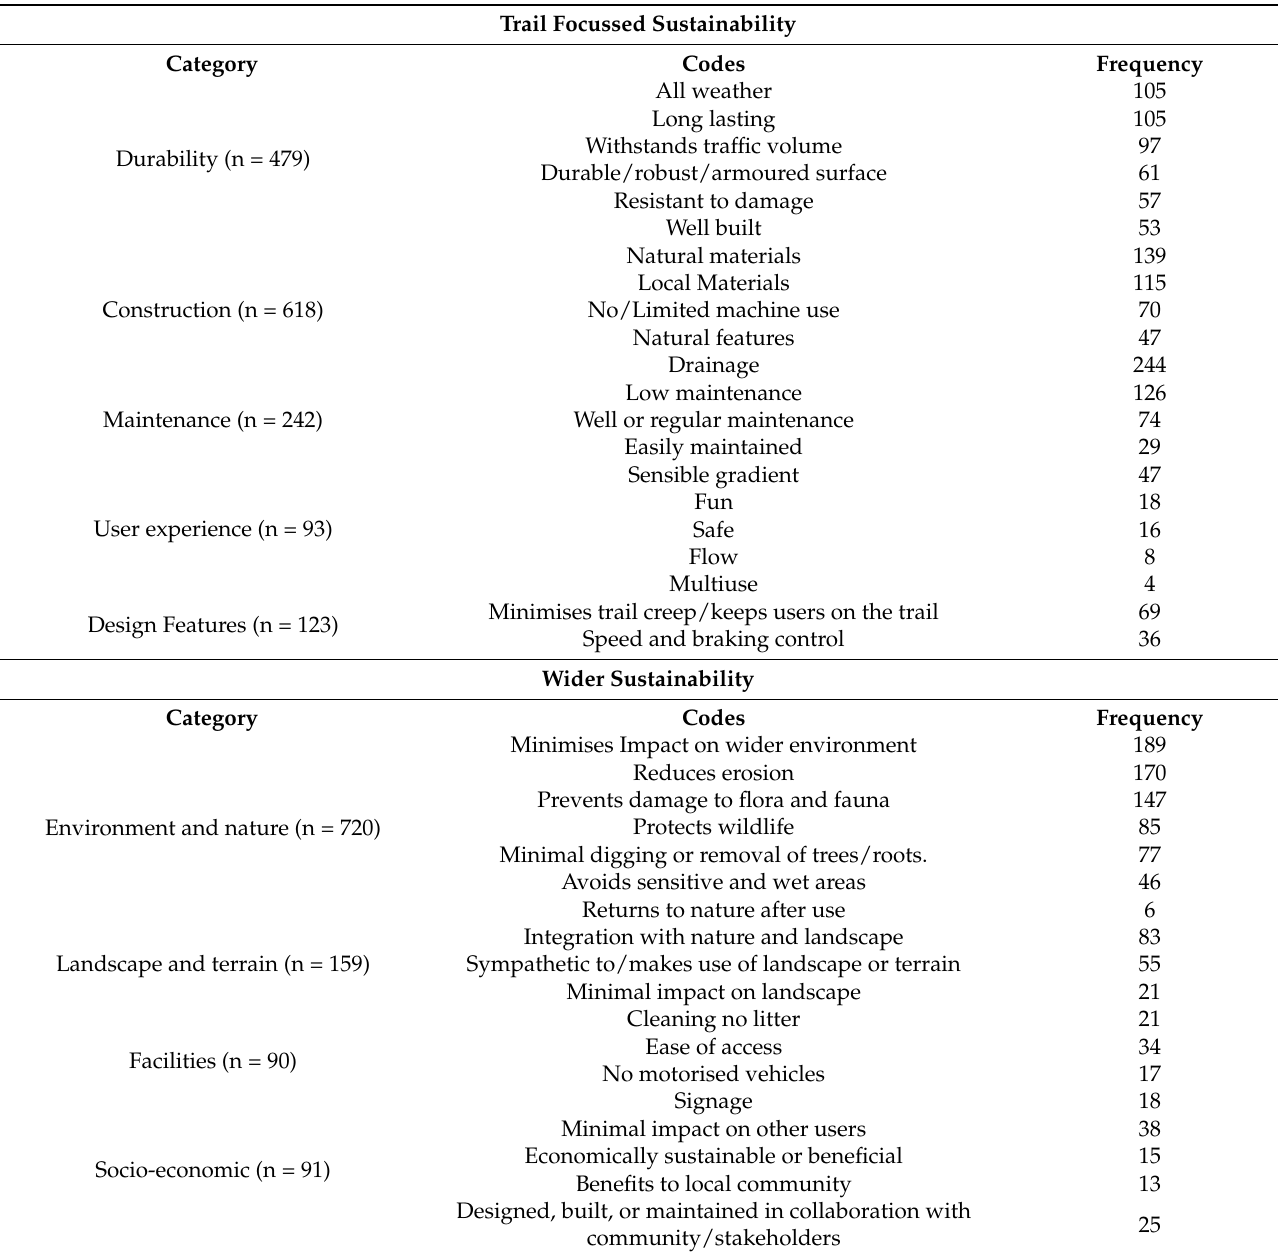
Table 6. Content analysis of the question, “What do you consider to be a sustainable trail?” (n =